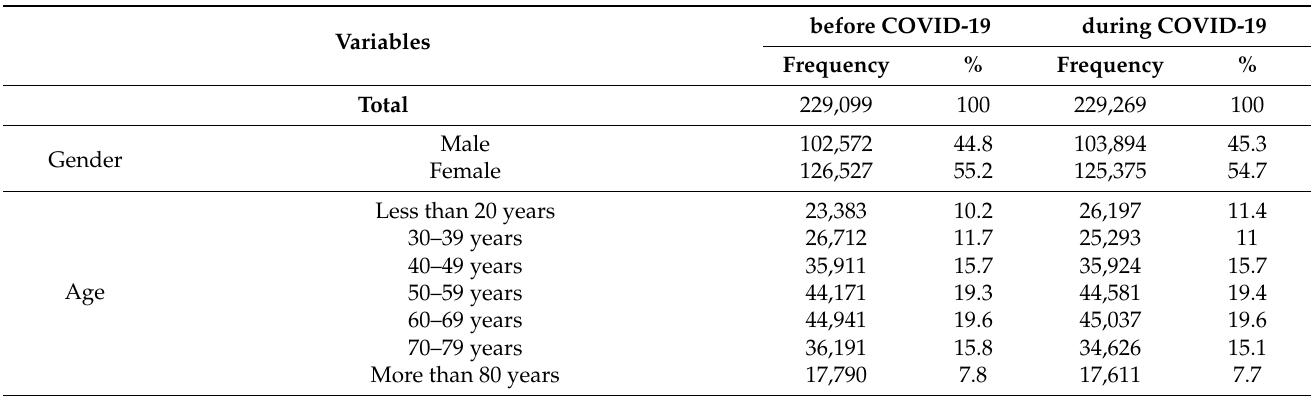
Table 1. Characteristics of participants.